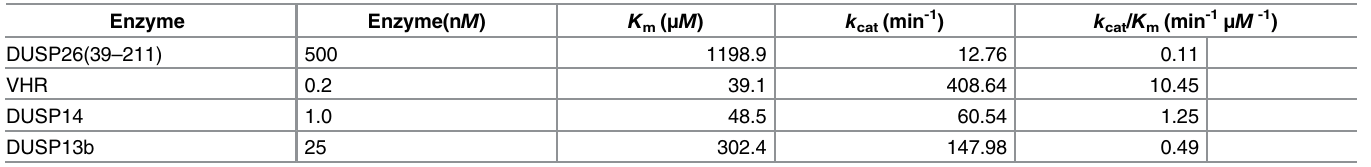
Fig 1. Phosphatase activity of DUSP26-N. (A) Sequence alignment of DUSP26 with DUSP27, VHR, and VH1 in the N-terminal region. The DUSP26-N (C152S) and DUSP26-C (C152S) constructs are shown and the location of the α 1-helix in DUSP27 is indicated. The identical residues and homologous residues are colored in dark and light blue, respectively. (B) Phosphatase activity measurements of DUSP26-N using DiFMUP as a substrate. Phosphatase activities of DUSP26-N wild-type (WT) (green), DUSP26-N (C152S) (red), and DUSP26-C WT (blue) were determined by monitoring the fluorescence emitted by the hydrolyzed DiFMU fluorogenic product. doi:10.1371/journal.pone.0162115.g001 Table 1. Kinetic data of DUSP26-N for catalysis of